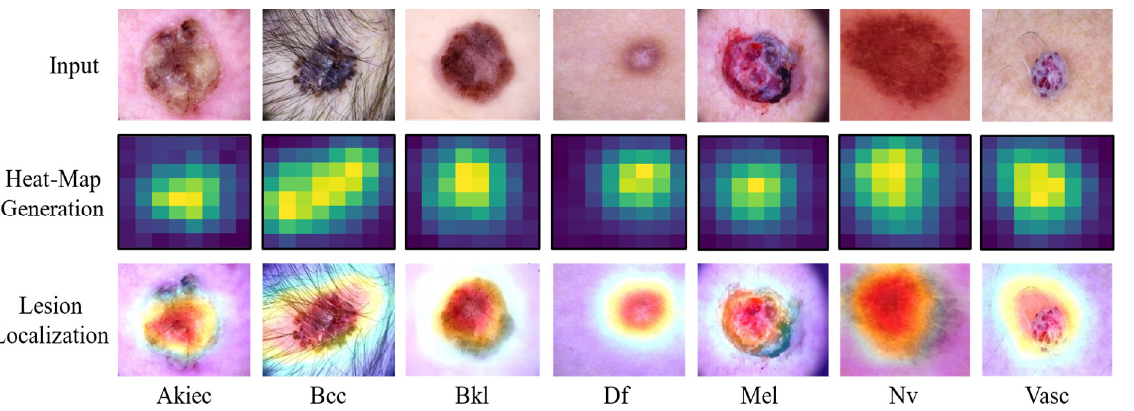
Figure 8. Samples of a heat-map for each class.